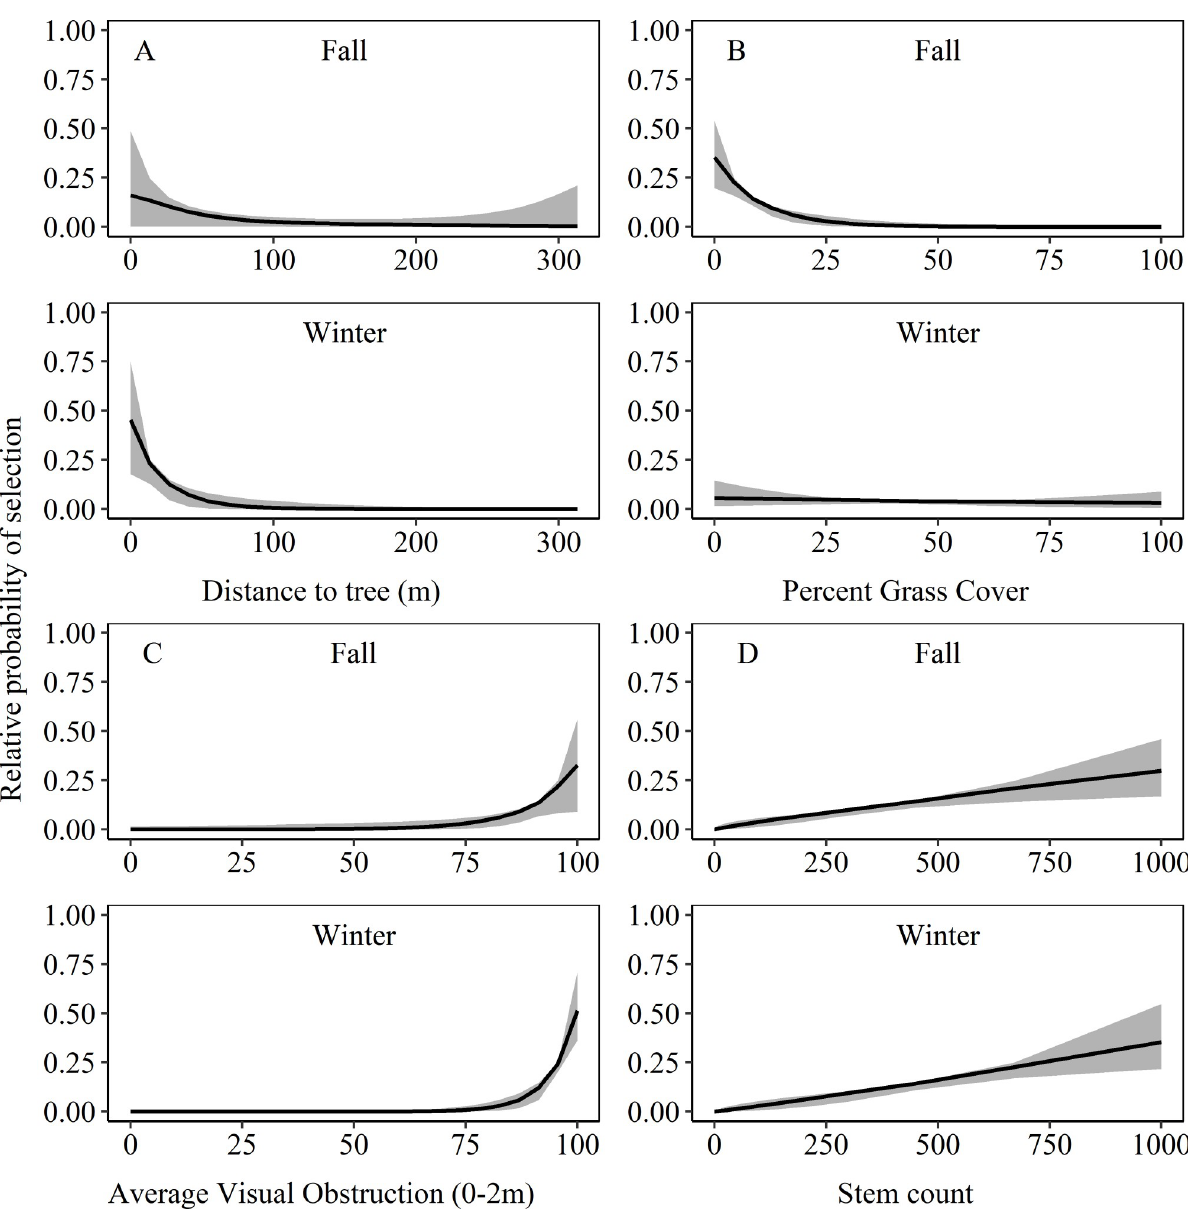
Fig 3. Mean relative probability of selection and 85% CRI for Northern bobwhite in fall and winter as function of the A) distance from the nearest tree (m), B) percent grass cover measured within 0.50-m 2 quadrat frame, C) average visual obstruction (0–2 m), and D) woody stem count with 5m